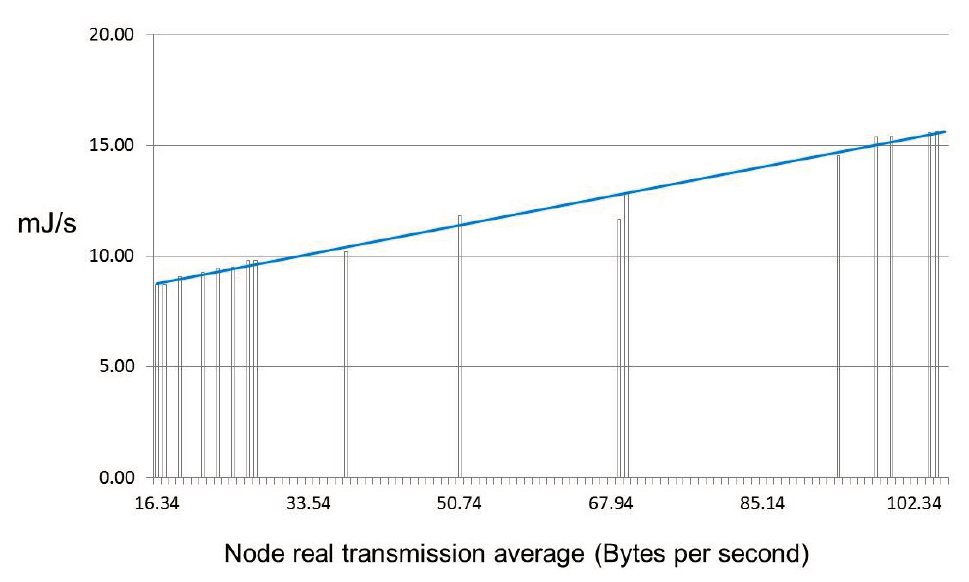
Figure 11. Energy consumption in 630 Bps ( j = [0…2]).